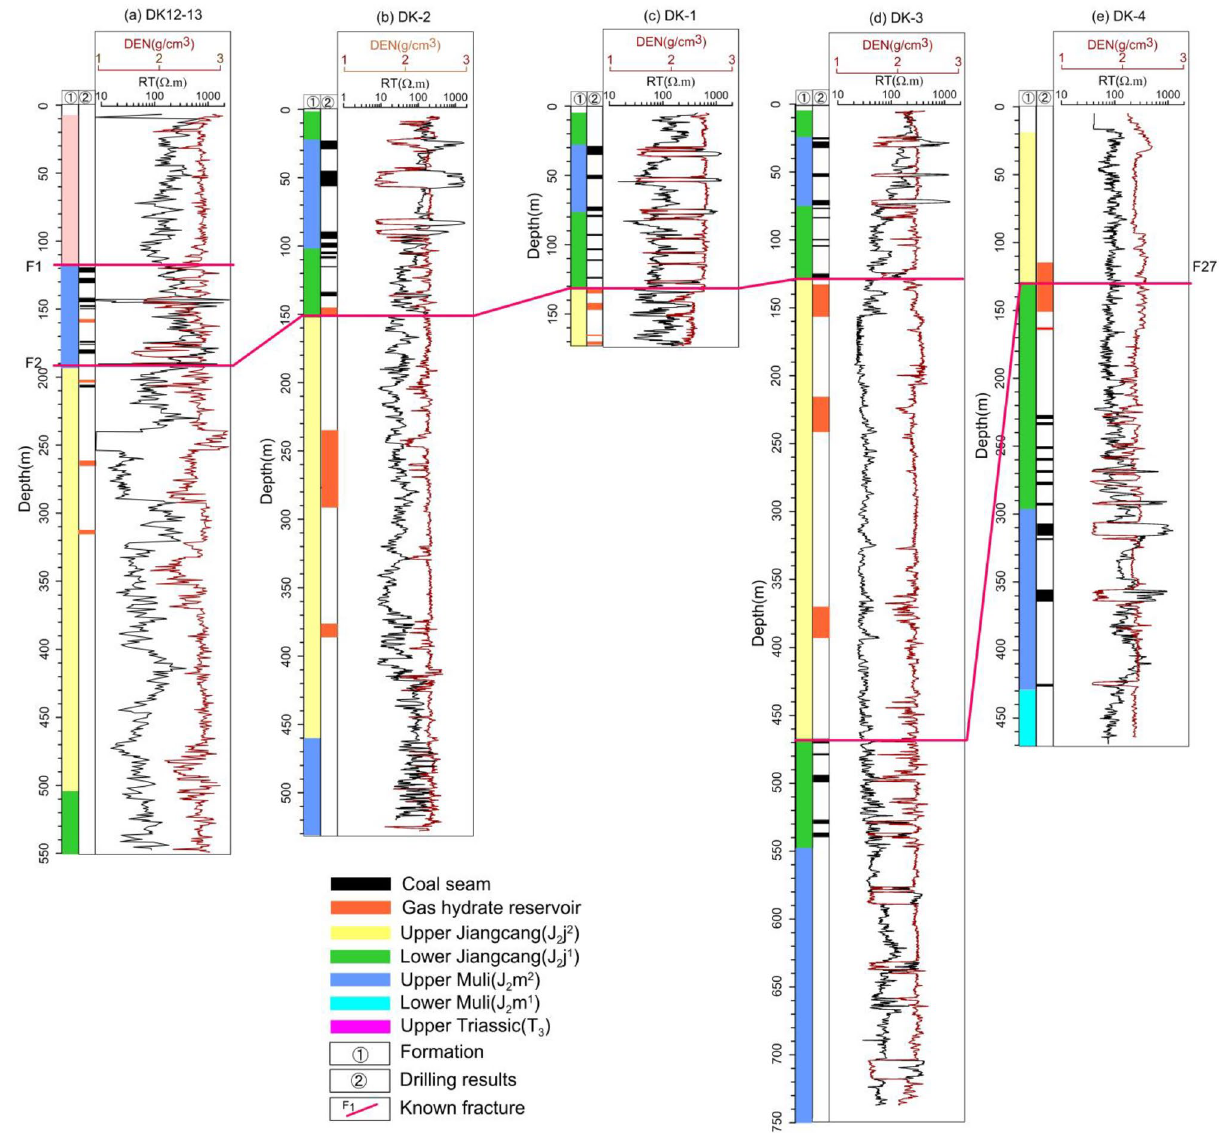
Figure 2. Resistivity versus depth from well logs: ( a ) DK12-13, ( b ) DK-2, ( c ) DK-1, ( d ) DK-3, and ( e )